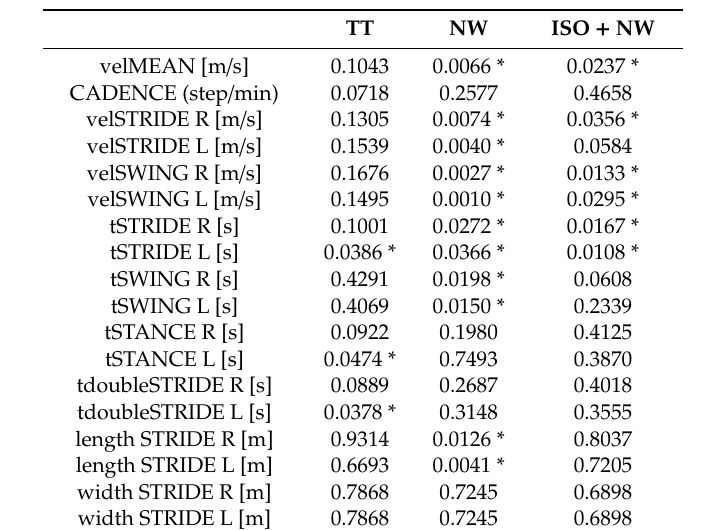
Table 4. Mean di ff erences in the spatiotemporal parameters of gait for each of the groups between tests 1 and 2.